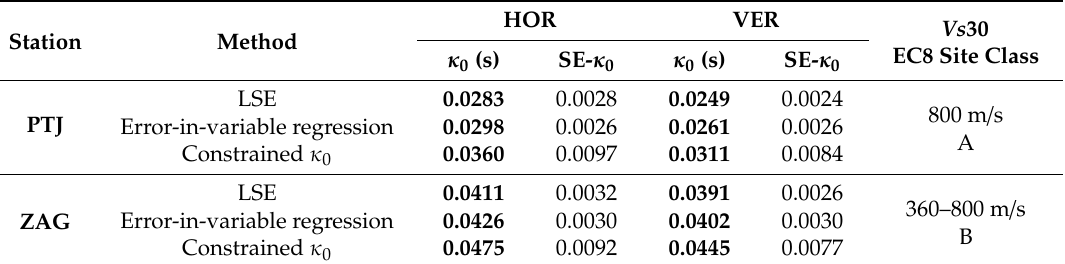
Table 2. Summarized κ 0 values estimated within di ff erent approaches compared with local site conditions based on the EC8 [41] site classification (based on approximation via correlation to topographic slope [39,40]. The range of the uncertainty with constrained κ 0 value is set to ± 1 standard